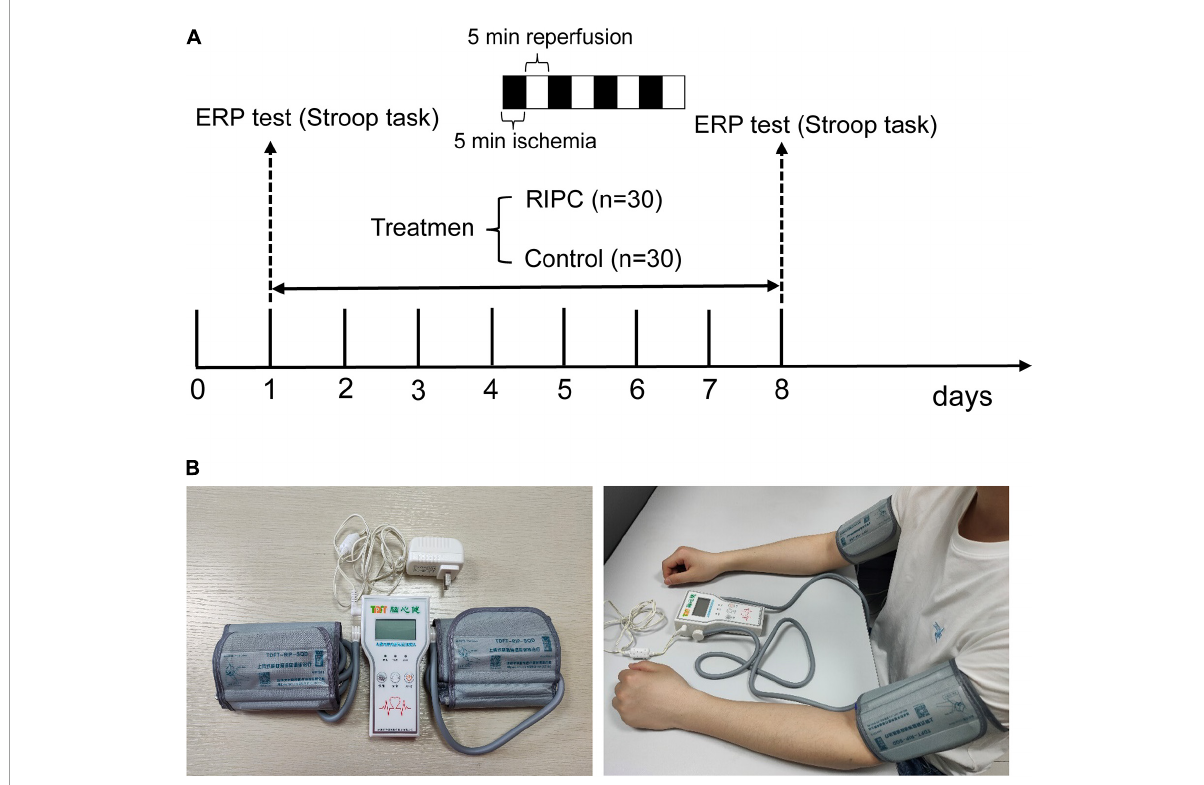
FIGURE1 The schematic diagram of the whole procedure, RIPC device, and the usage diagram. (A) The Stroop task and event-related potentials (ERPs) were adopted to evaluate cognitive control ability before and after RIPC treatment. The RIPC group ( n = 30) was assigned to accept 40 min per day for a total of 7 days of RIPC treatment, four cycles of 5 min ischemia (180 mmHg) and 5 min reperfusion were performed on the bilateral upper limb, and the control group ( n = 30) were not accepted RIPC. (B) The RIPC device (left image) and how it is used (right image), the consent statement about the human image has been